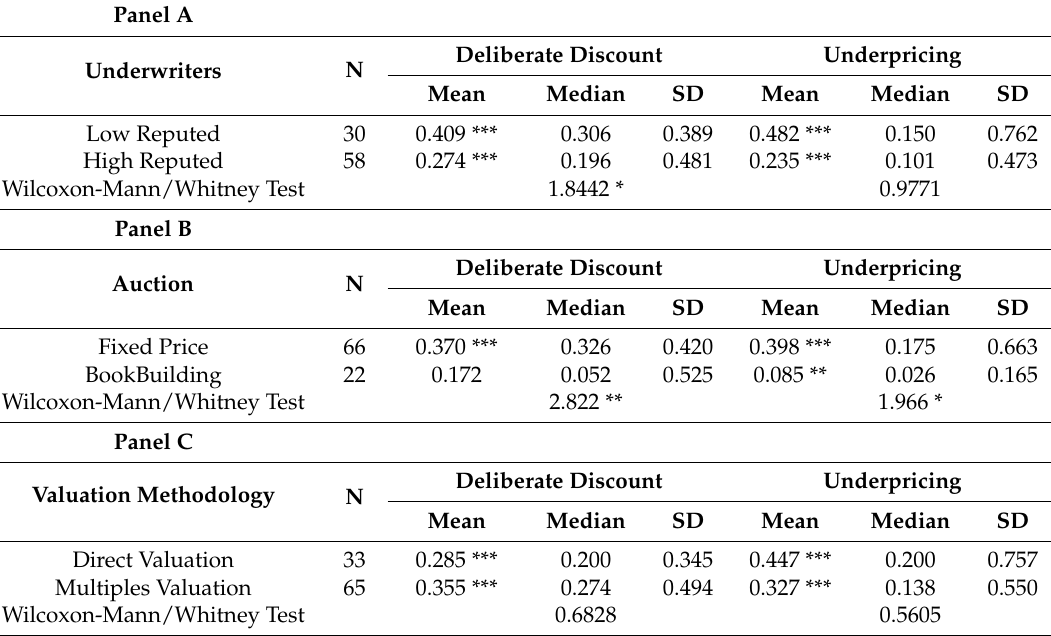
Table 8. Underpricing and Underwriter’s deliberate discount